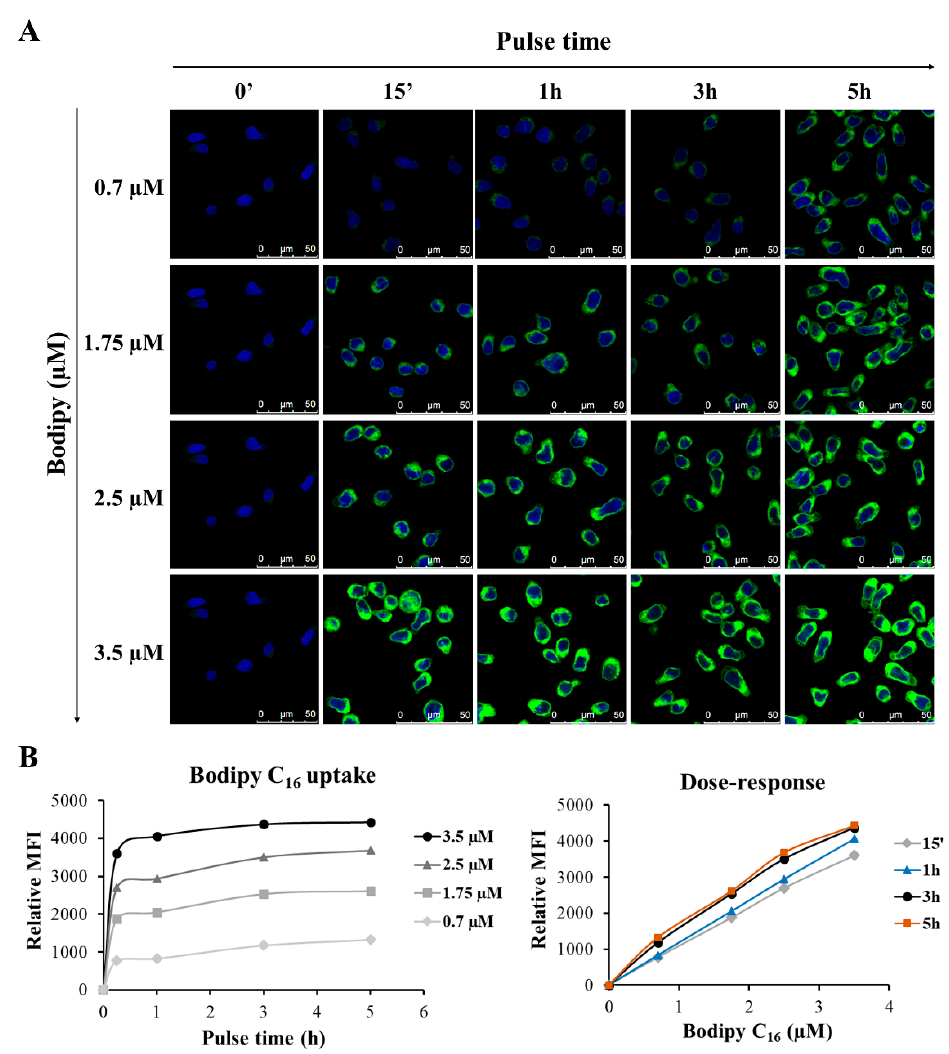
Figure 9. Bodipy C 16 uptake by GEN2.2 cells. A total of 0.3 × 10 6 GEN2.2 cells were pulsed for different times with different concentrations of Bodipy C16 (green), as indicated in the figure. ( A ) For confocal microscopy analysis, cells were placed on a microscope slide and fixed in PFA 4%. To visualize nuclei (blue), GEN2.2 cells were stained with DAPI. Images were acquired with the confocal microscope Leica TCS SP5 and processed with the software LAS AF version 1.6.3 (Leica Microsystems). Objective 63.0X. DIC: Differential Interference Contrast. Scale bars 0–50 µ m. ( B ) Cell fluorescence was analysed by FC and expressed as relative MFI (mean fluorescence intensity). A representative experiment, out of three independent experiments that yielded similar results, is shown.